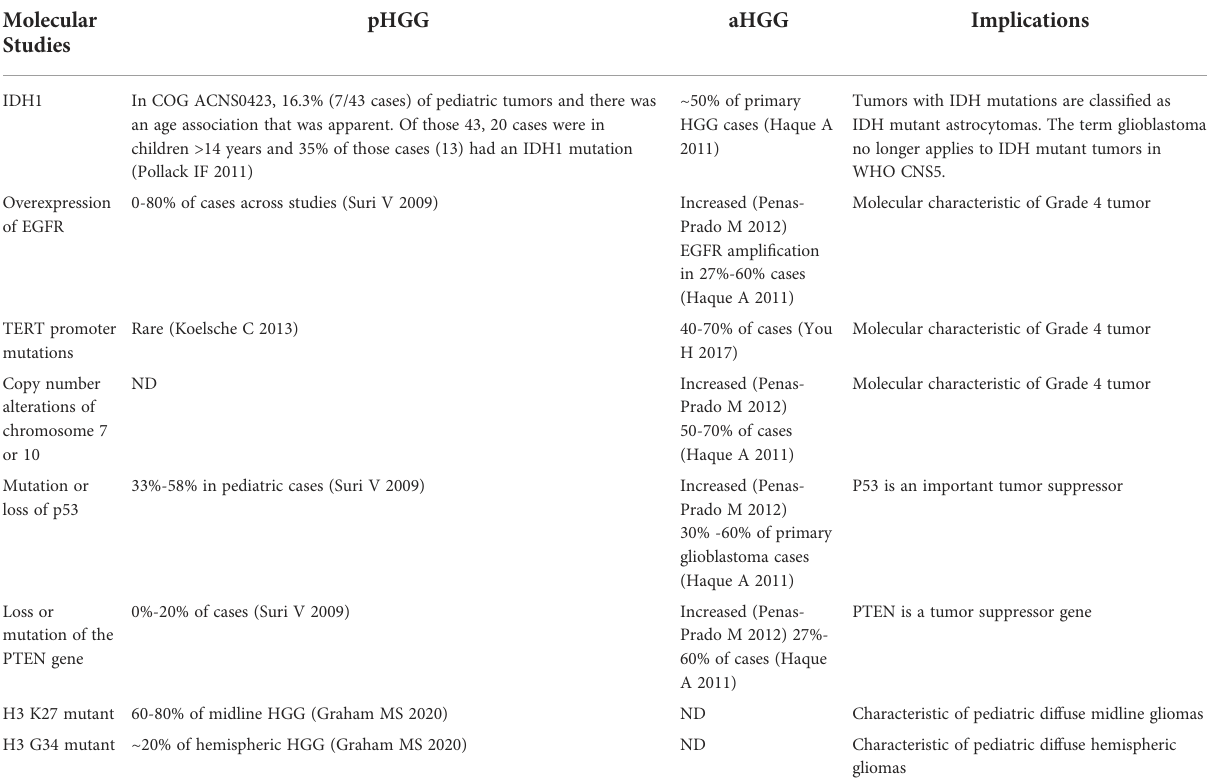
TABLE 1 Molecular pro fi ling of pediatric and adult high grade glioma. Molecular